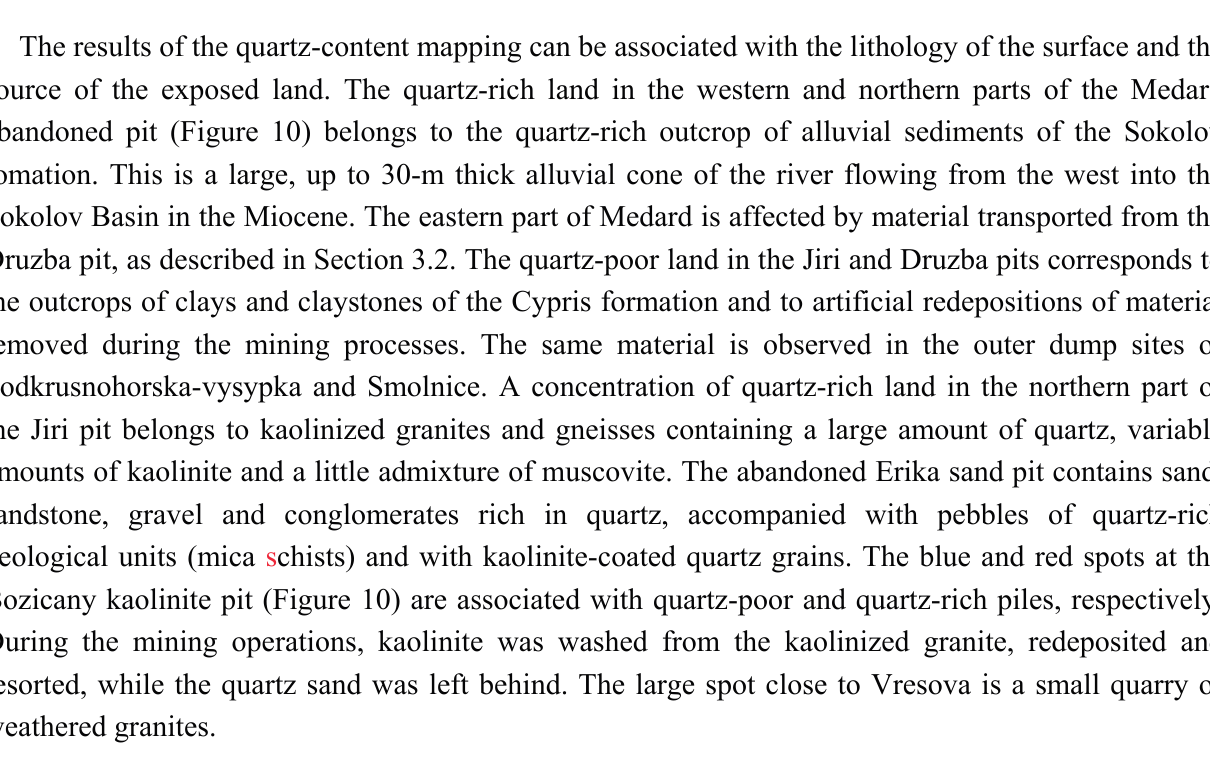
Figure 10. Quartz content in exposed land in the Sokolov lignite mining